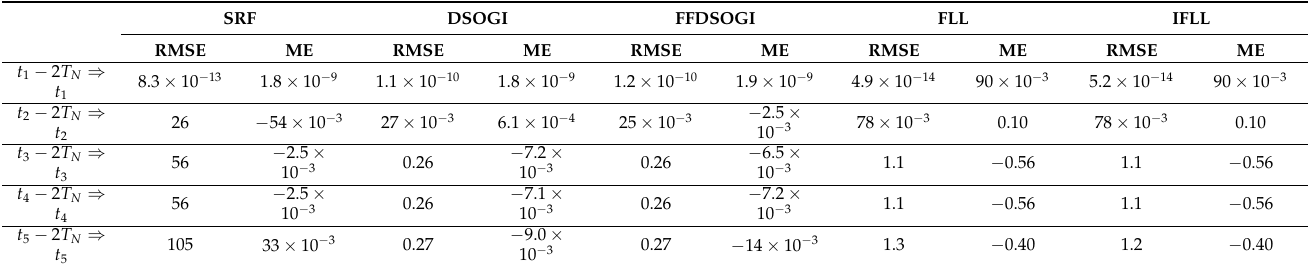
Table 5. Steady-state estimated frequency RMSE and ME obtained during test